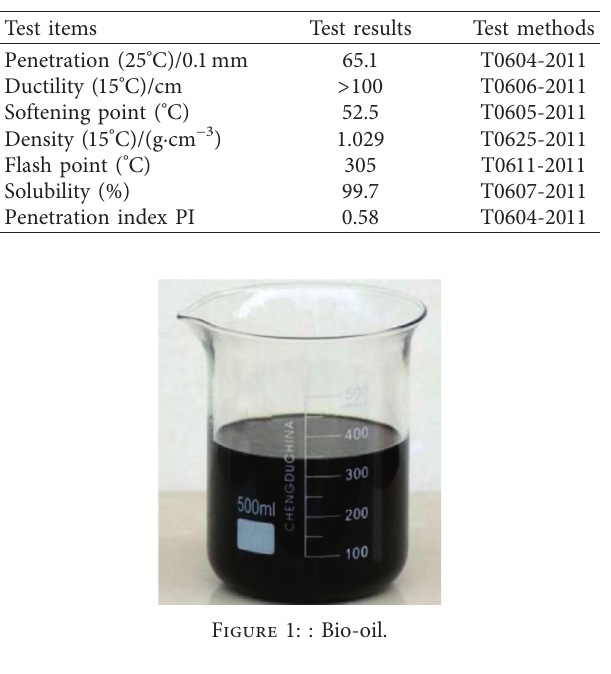
Figure 1: : Bio-oil.